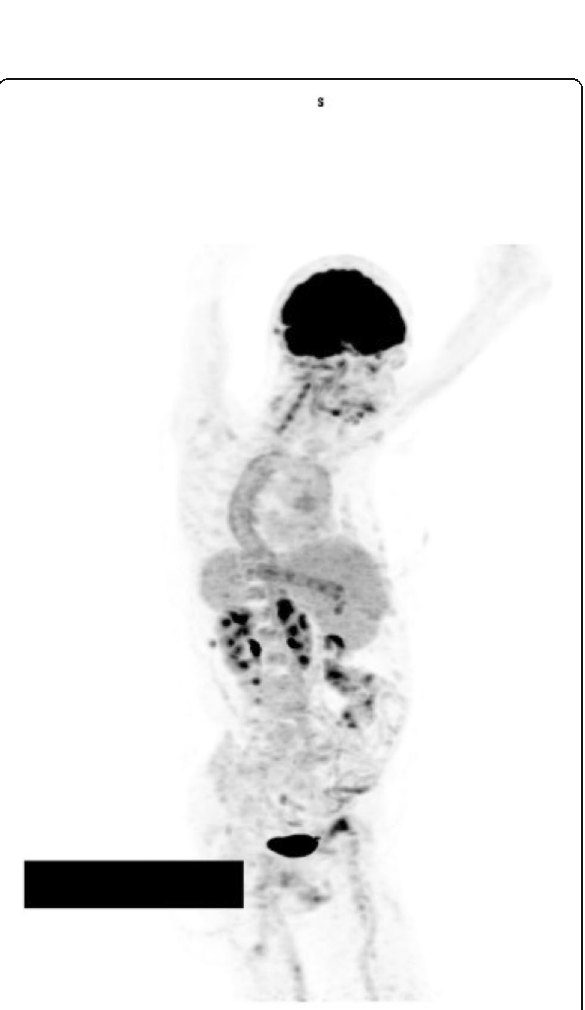
Fig. 3 Whole body FDG-PET image illustrating increased metabolic activity in the aorta (most pronounced in the descending part) as well as some of its main branches (including both vertebral arteries, more pronounced on the